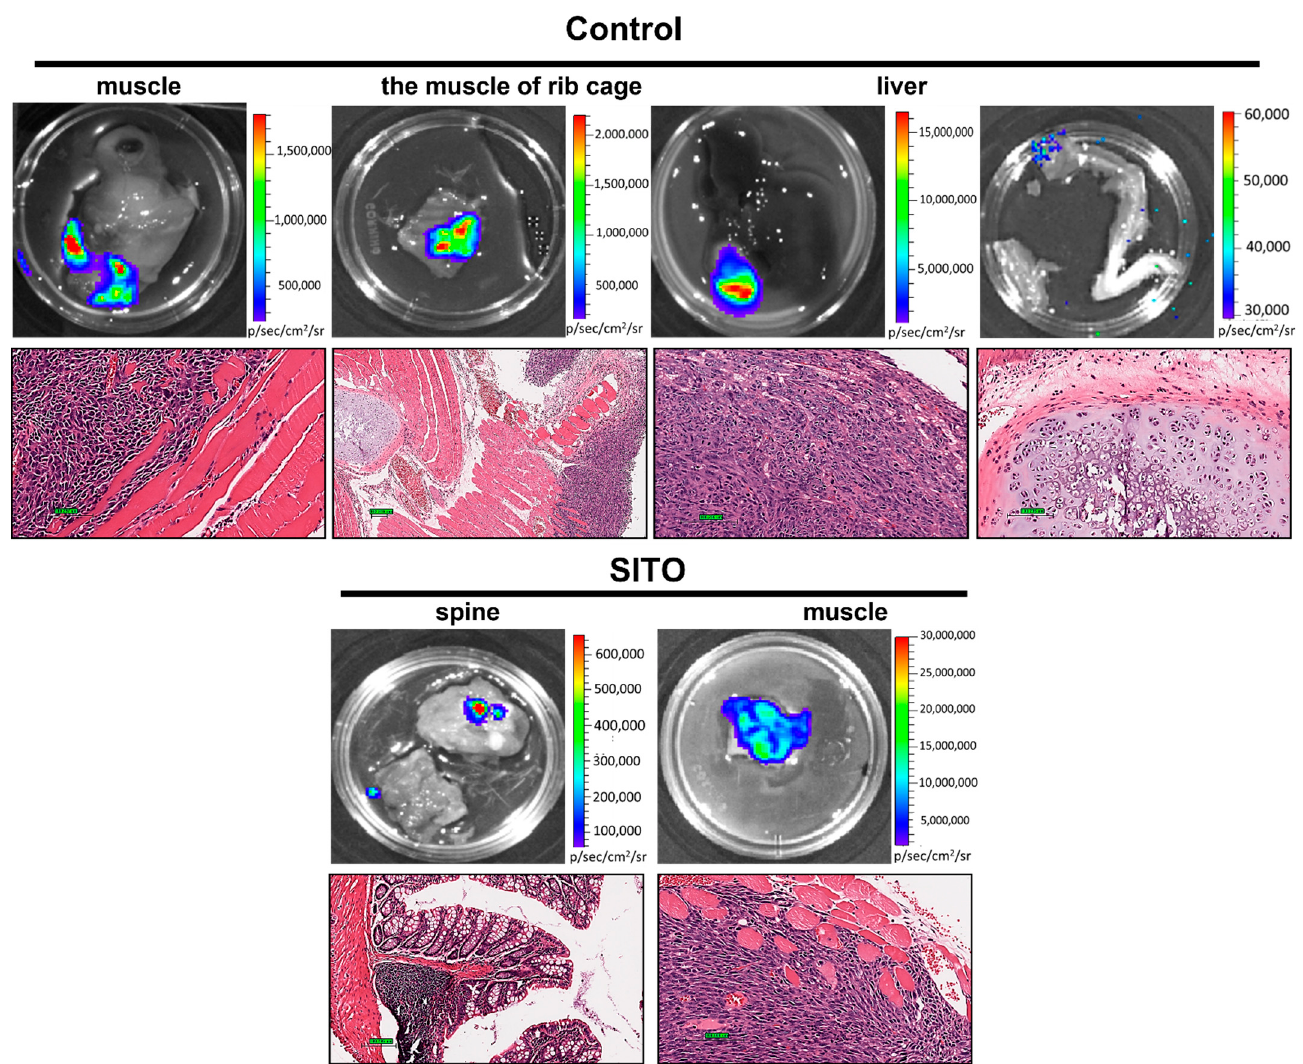
Figure 5. Liposomal β -sitosterol (LS) treatment effectively suppresses distal metastases in mice receiving an intravenous injection of CT26/ luc cells, as presented by ex vivo BLI and a histopathologic analysis. Ex vivo BLI was performed on 11 different tissues excised from each mouse after the final BLI, and the metastases were validated by H&E staining. Scale bar = 100 μ m. Table 1. The number of metastatic lesions was determined using a combination of ex vivo BLI and a histological analysis of all mice upon sacrifice.